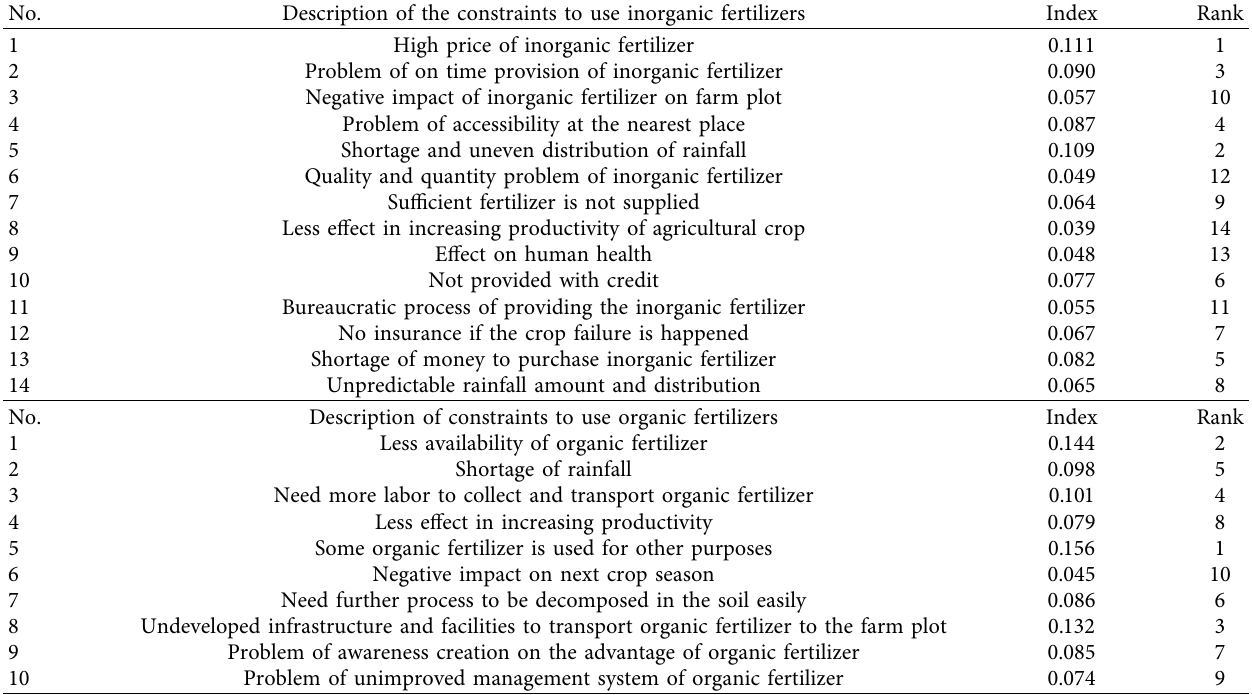
Table 4: Constraints of adoption of inorganic and organic fertilizers and their rank indexes.